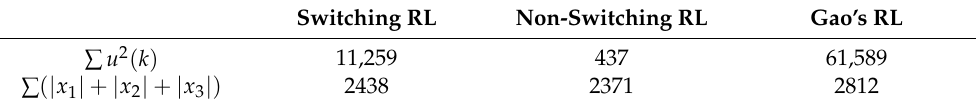
Table 1. Comparison of the controllers.